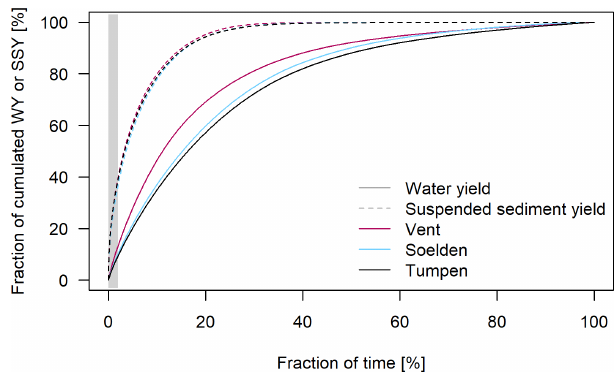
Figure 10. Duration curves of water and suspended sediment yield based on 15min data. The grey area represents the percentage of time classified as events. Note that the three lines for suspended sediment are very similar and might appear as only one